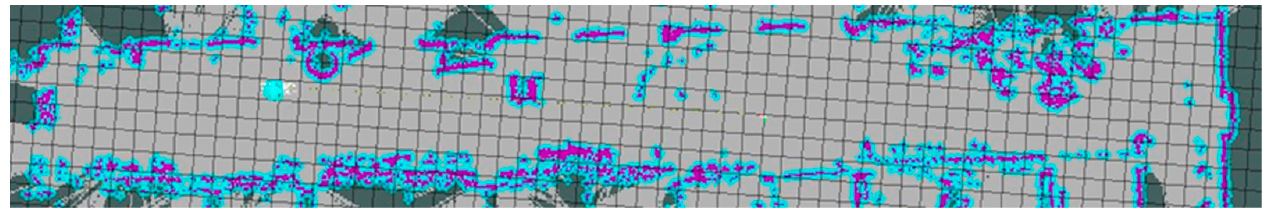
Figure 12. Real scene construction effect.